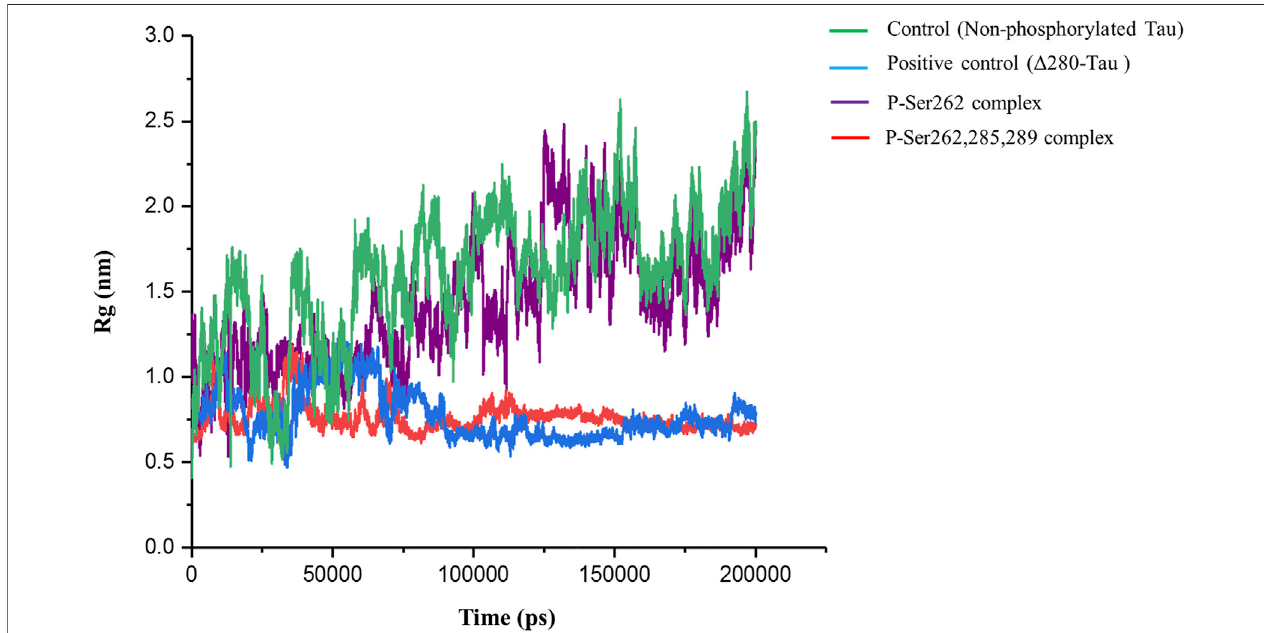
FIGURE 4 | Change in the radius of gyration (Rg) of the two docked segments in the control (non-phosphorylated tau), positive control ( Δ 280-tau), and the complexes with one (P-Ser262) and three (P-Ser262, 285, and 289) phosphorylated sites during 200 ns simulations. Rg values were increased mainly in the P-Ser262 compared to the P-Ser262, 285, 289.